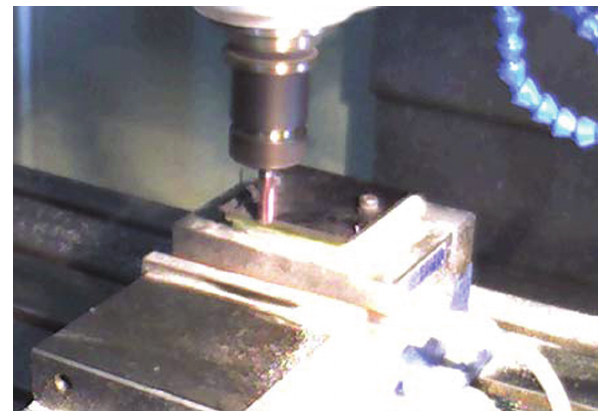
Figure 4 Experimental setup for end